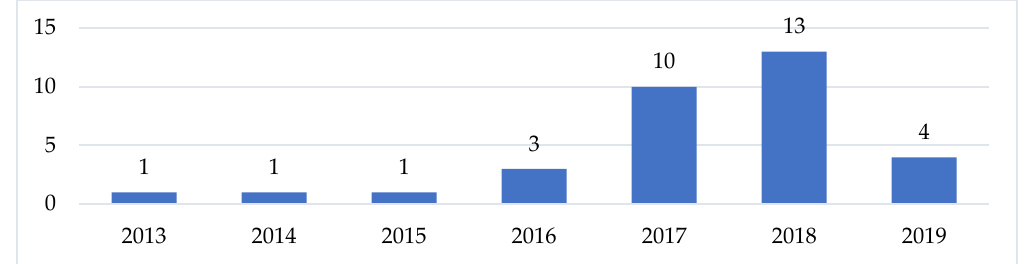
Figure 2 . Distribution of the publications by year.